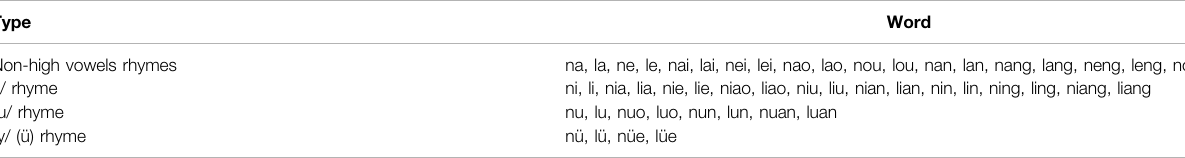
TABLE 3 | Standard Mandarin word list with initial /l/ and /n/.